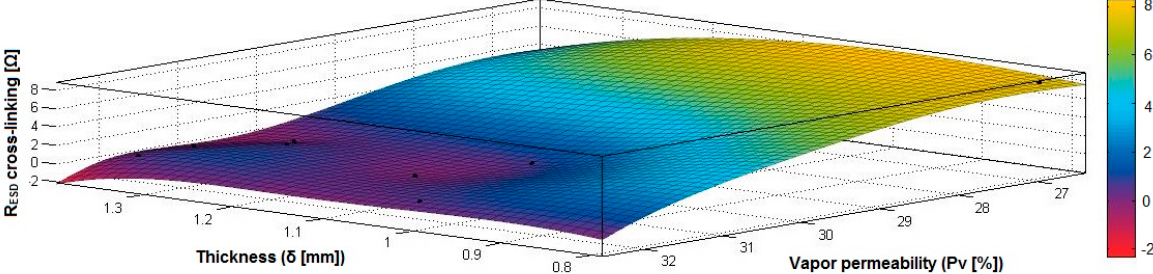
Figure 28. 3D representation R ESD after crosslinking = f(Pv, δ ) samples preliminarily treated in RF plasma O 2 using RF 1 generator and power 200 W.